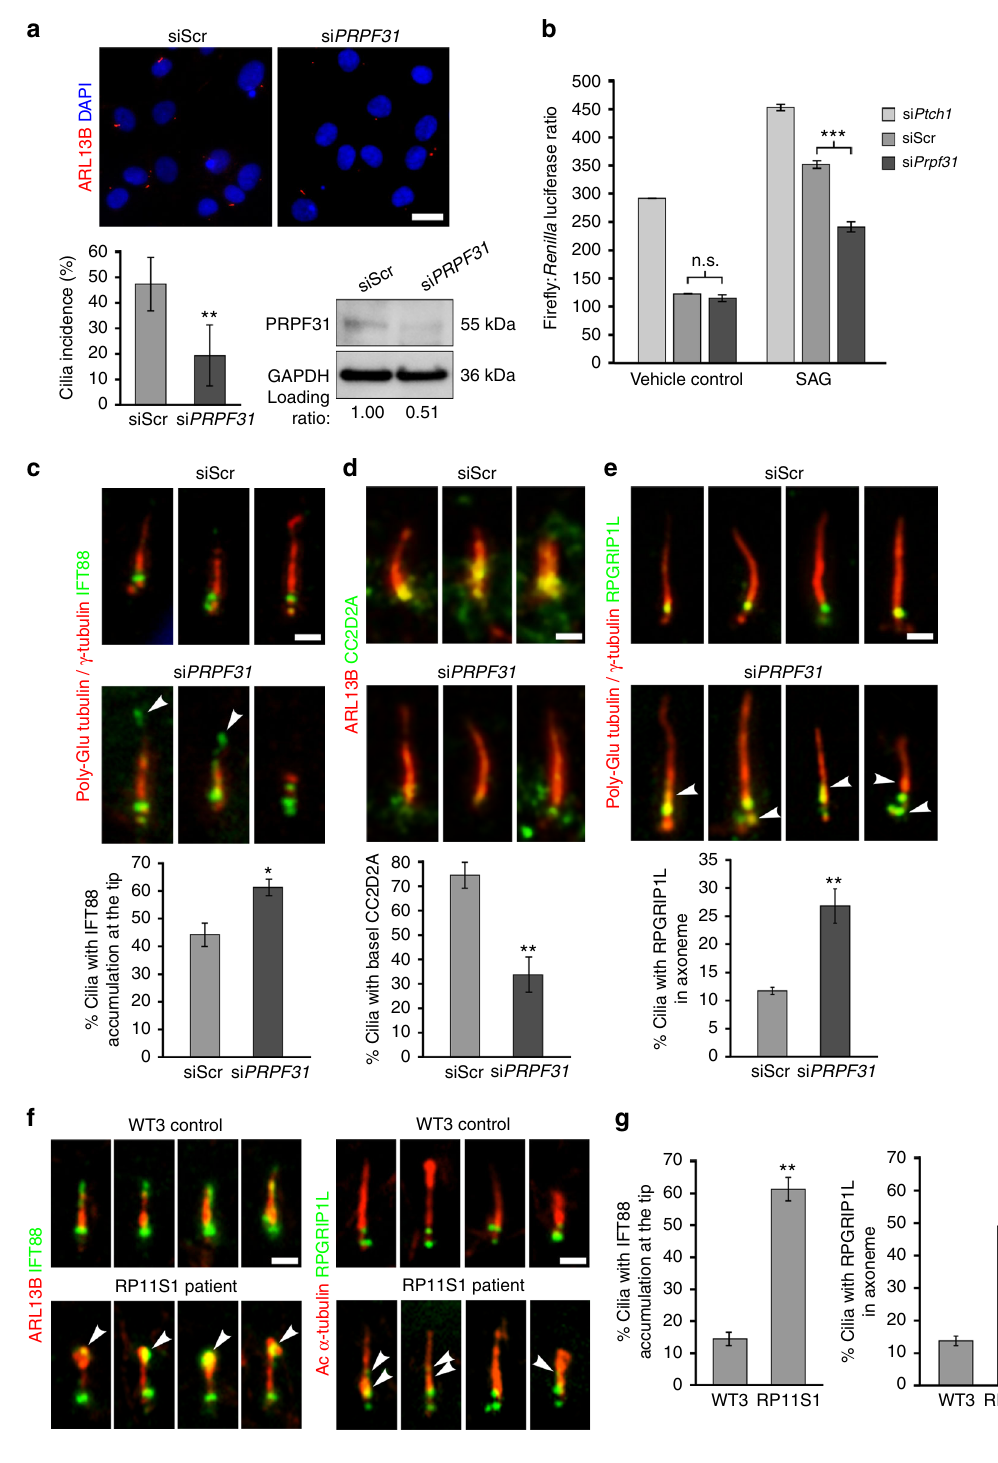
mRNA processing factors (PRPFs). PRPFs are ubiquitously expressed and involved in the formation of stable U4/U6.U5 tri- snRNPs and the spliceosomal B complex leading to spliceosome activation, yet human PRPF mutations result in retinal-speci fi c phenotypes. Despite a large body of work in immortalised cell lines and animal models, there are no described cellular pheno- types for PRPF31 -related RP type 11 that de fi ne the primary affected cell type or provide clear insights into the patho- mechanisms that can explain the retinal speci fi city of